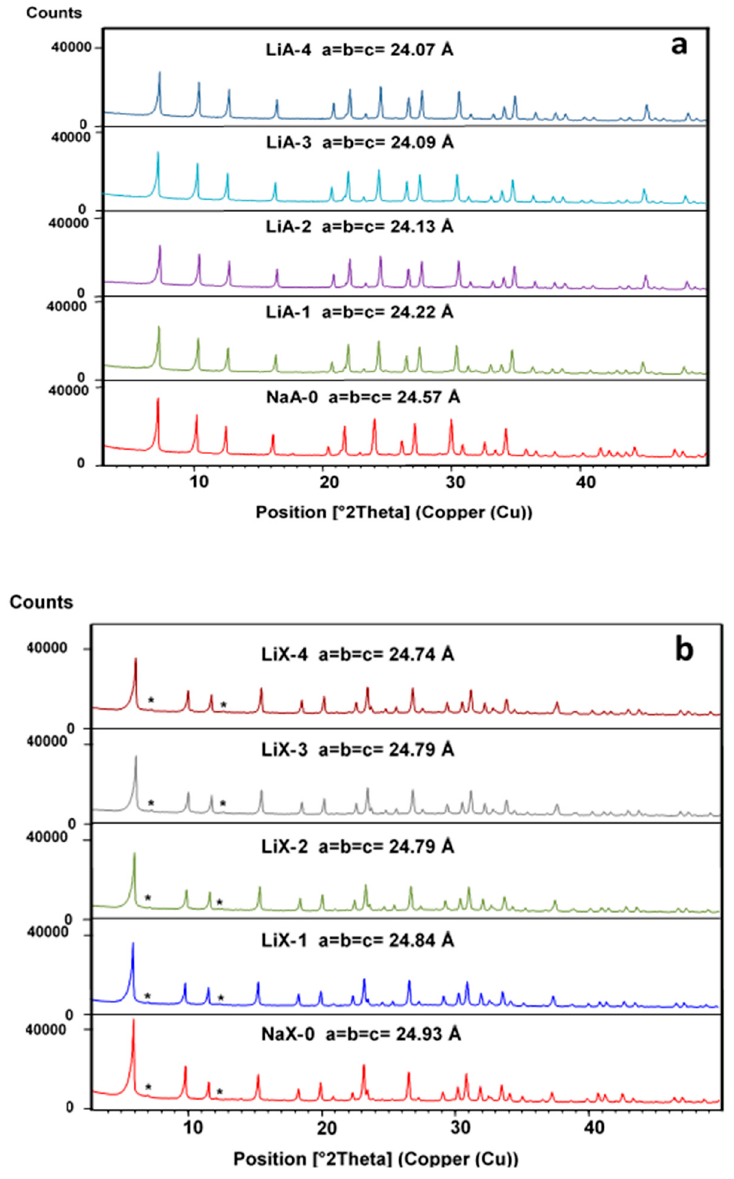
Figure A1. XRD patterns of ( a ) raw and Li+ exchanged LTA-type zeolite and ( b ) raw and Li+ exchanged FAU-type zeolite. * Traces of LTA-type zeolites.